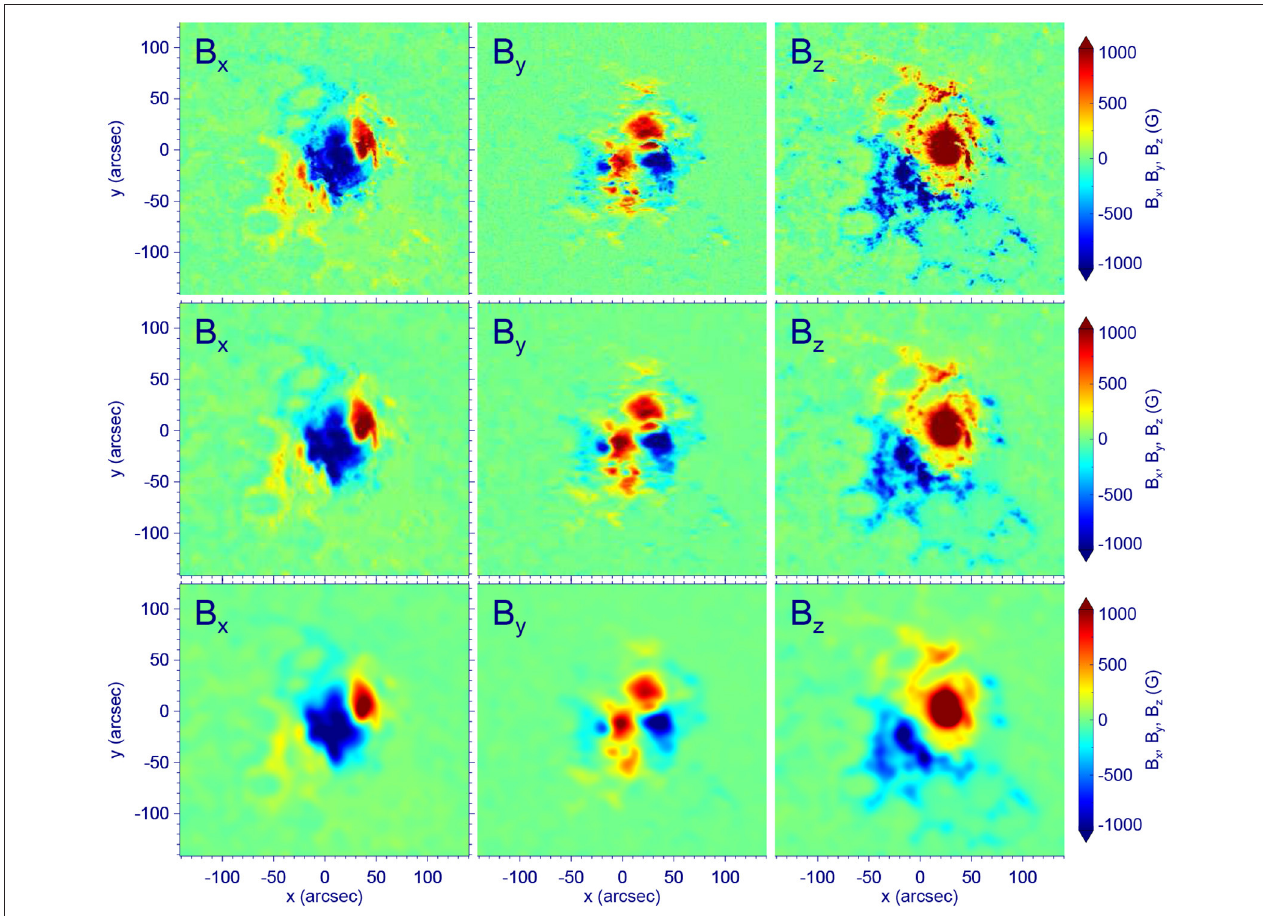
FIGURE 1 | Comparison of the original HMI vector magnetogram for time of 00:00 UT on 2014 September 8 (Top) , the preprocessed one (Middle) , and the final smoothed one (Bottom) . From left to right are shown for magnetic field components B x , B y , and B z ,